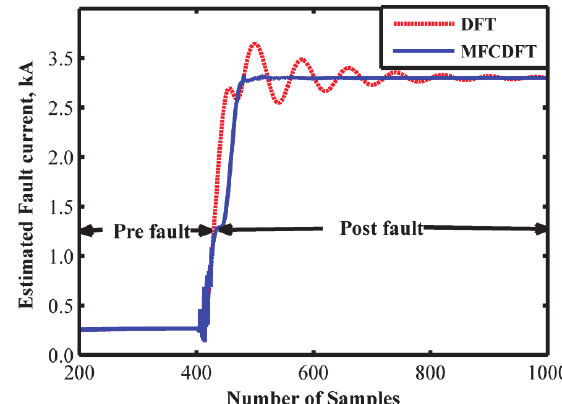
Fig. 7. Phasor estimation for fault current using DFT and MFCDFT during L-G fault applied at 0.1 s (400 samples) with FIA =